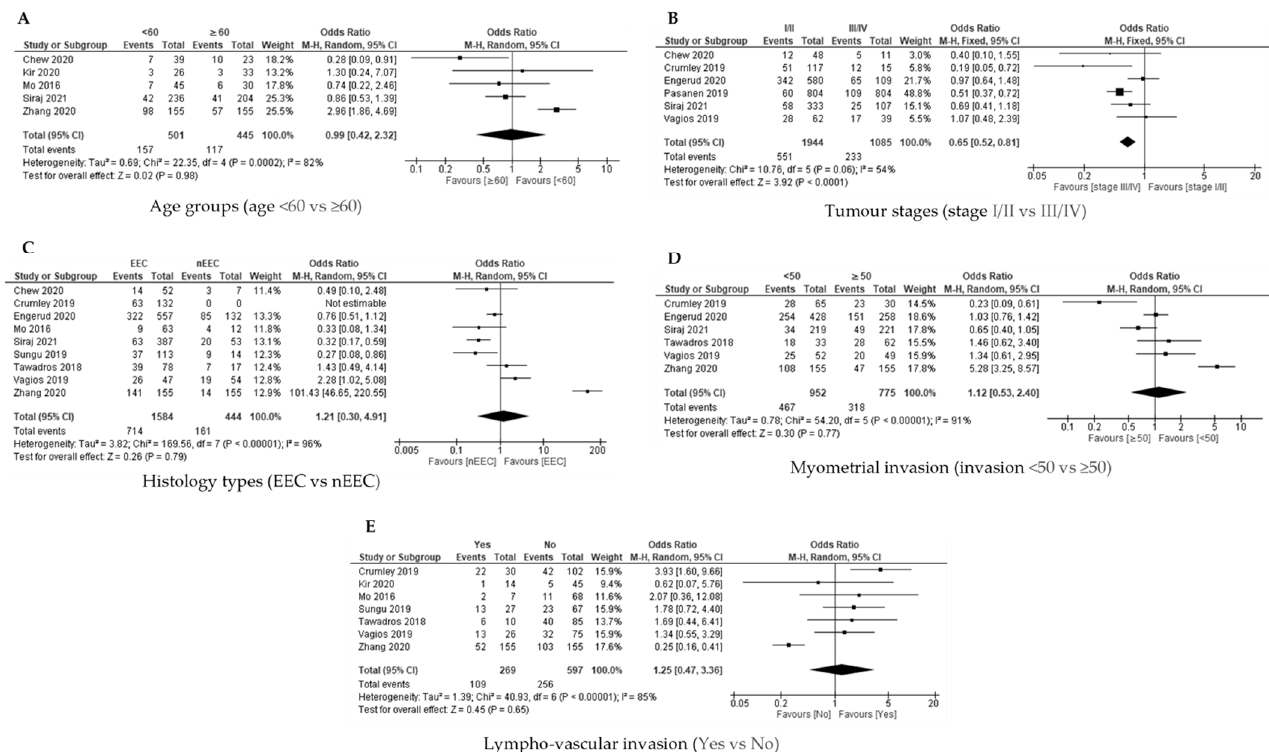
Figure 4. The PD-L1 positive expression among the endometrial cancer cases in tumour cells (TCs) [17–19,24–31]. Forest plot of ( A ) age group, ( B ) tumour stage, ( C ) histological type, ( D ) myome- trial invasion, ( E ) lympho-vascular